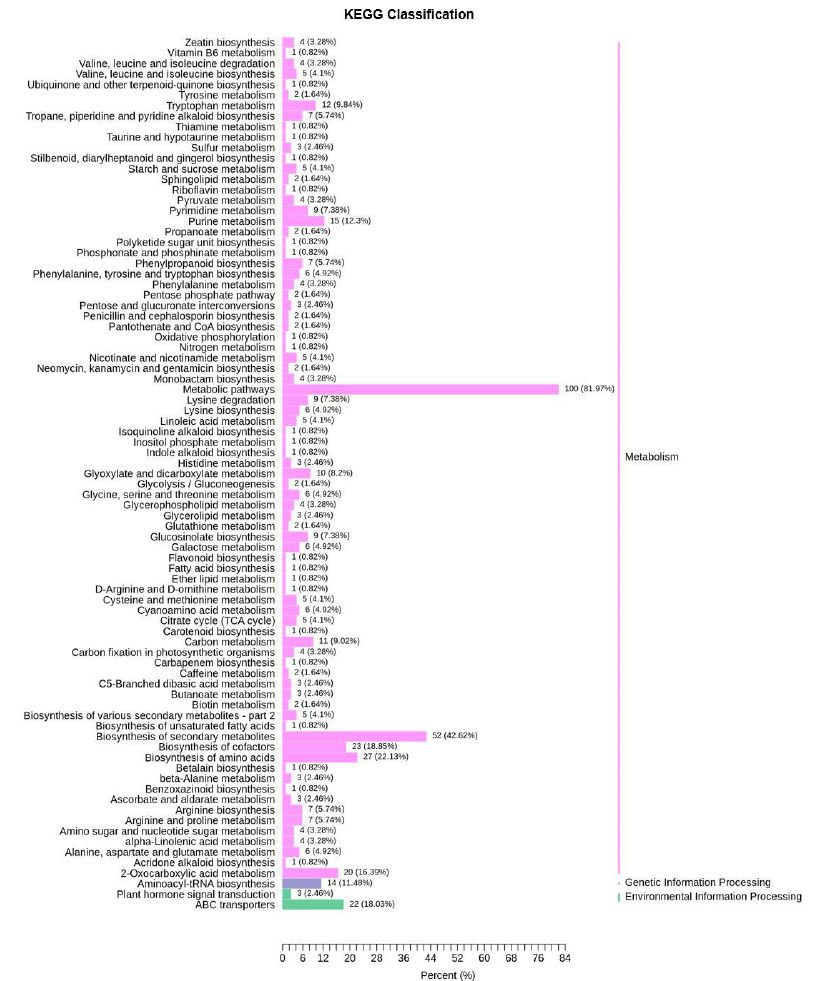
Figure 4. KEGG pathway analysis of 291 differential metabolites of drought − tolerant and susceptible genotypes in response to drought stress.